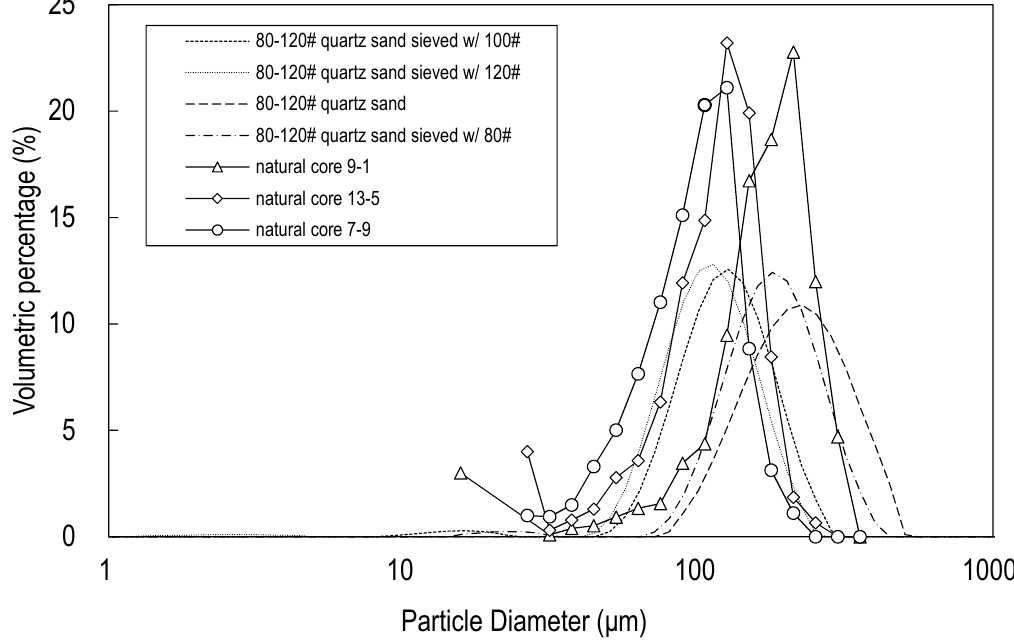
Figure 6. Loose sand processing for matching of the particle size distribution for sample 9-1, 7-9 and 13-5. Solid lines with Δ , ◊ , ○ are particle size distribution of target natural cores 9-1, 13-5, and 7-9 respectively by thin section testing. The dotted lines (---) in the figures are particle size distribution of 80–120# sands sieved at different mesh size by laser diffraction particle size distribution testing.